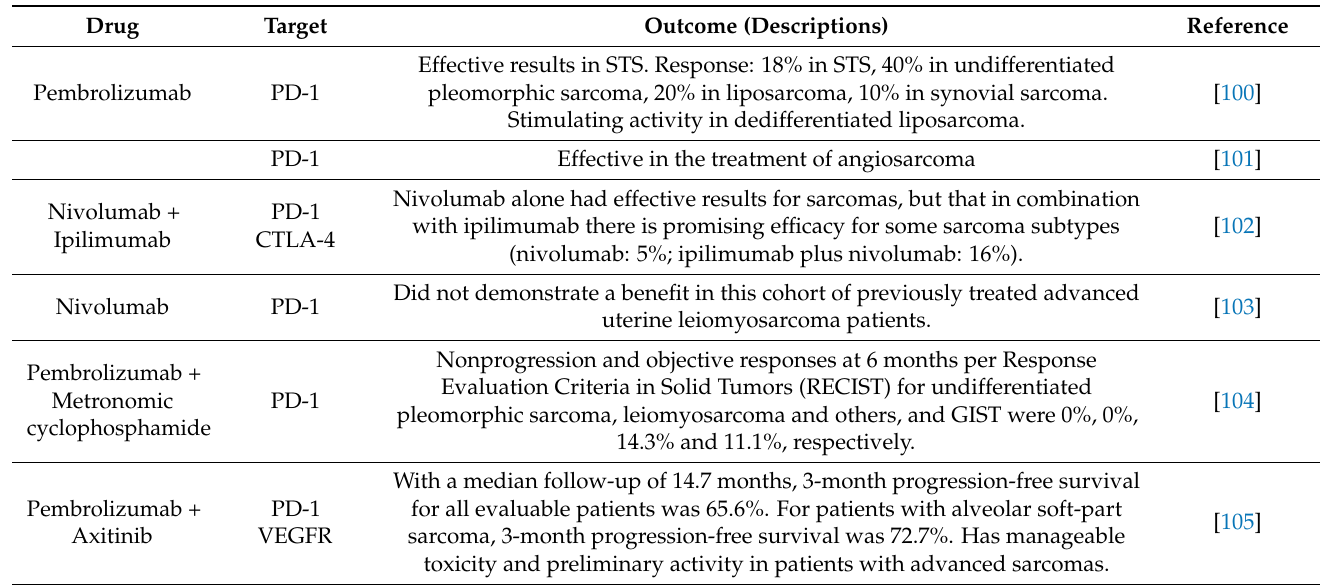
Table 1. Antibody-based immunotherapies in soft tissue sarcoma (completed clinical